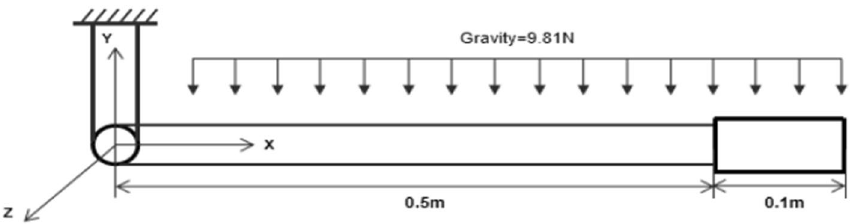
Figure 4. Rigid-flexible coupling model diagram with one rigid body at the